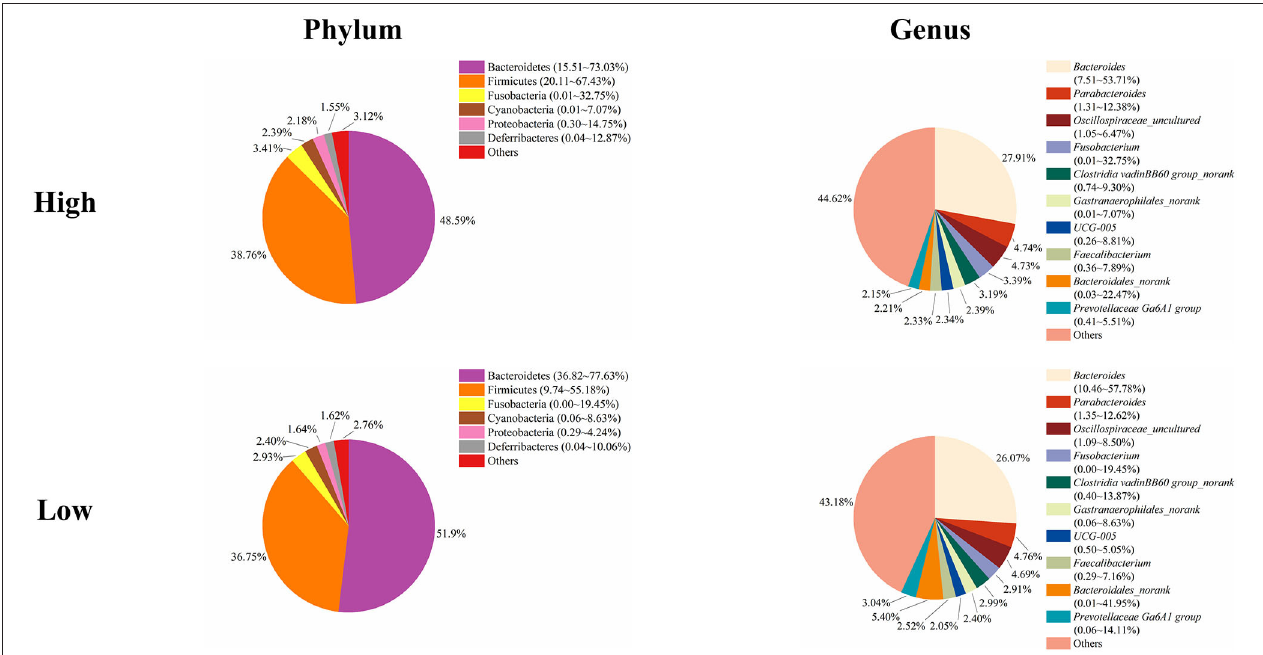
FIGURE 5 | The microbial composition in the cecum of the high and low group ducks.